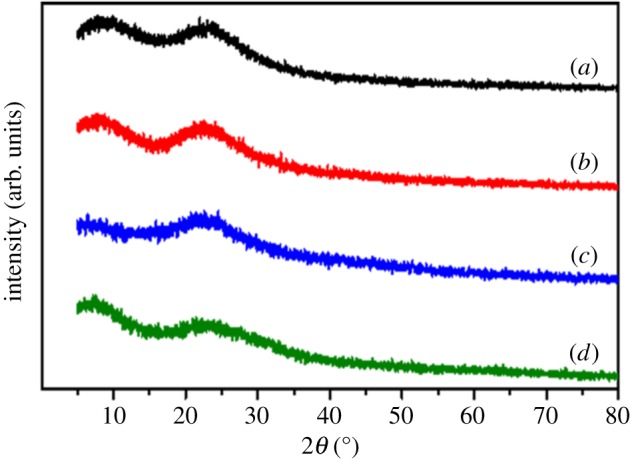
XRD pattern of SiO2 (a), SiO2@ANA-Si (b), SiO2@ANA-Si-Tb (c) and SiO2@ANA-Si-Tb@SiO2 (d).